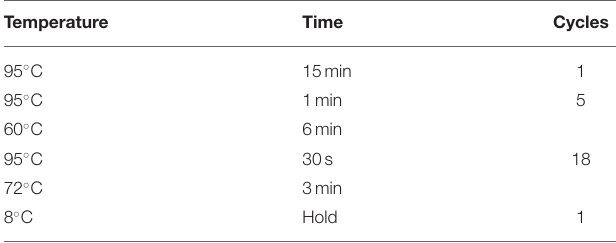
TABLE 1 | The procedure details of the first round of PCR (“gene-specific PCR”).